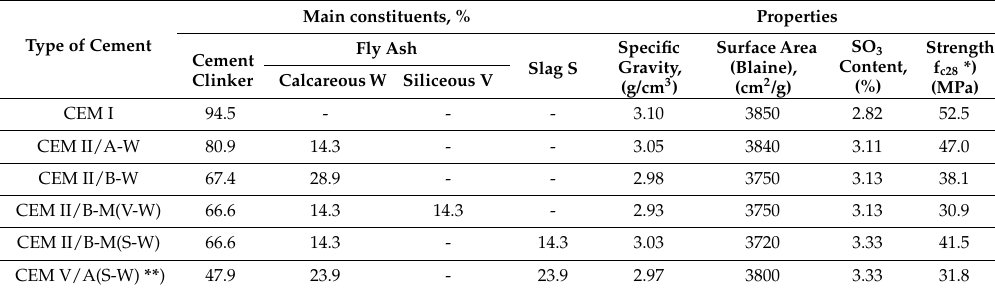
Table 2. The composition and physical properties of blended cements containing calcareous fly ash W (data provided by The Institute of Ceramics and Building Materials in Cracow, Poland) [18]. Main constituents, % Type of Cement